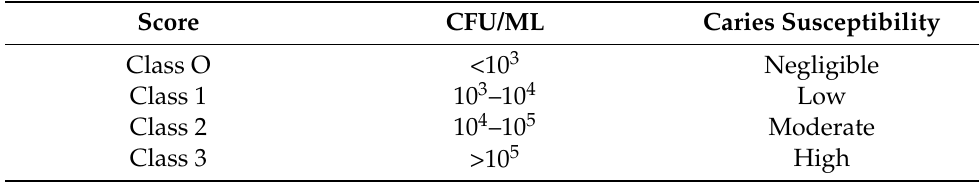
Table 1. Parameters for calculating S. mutans